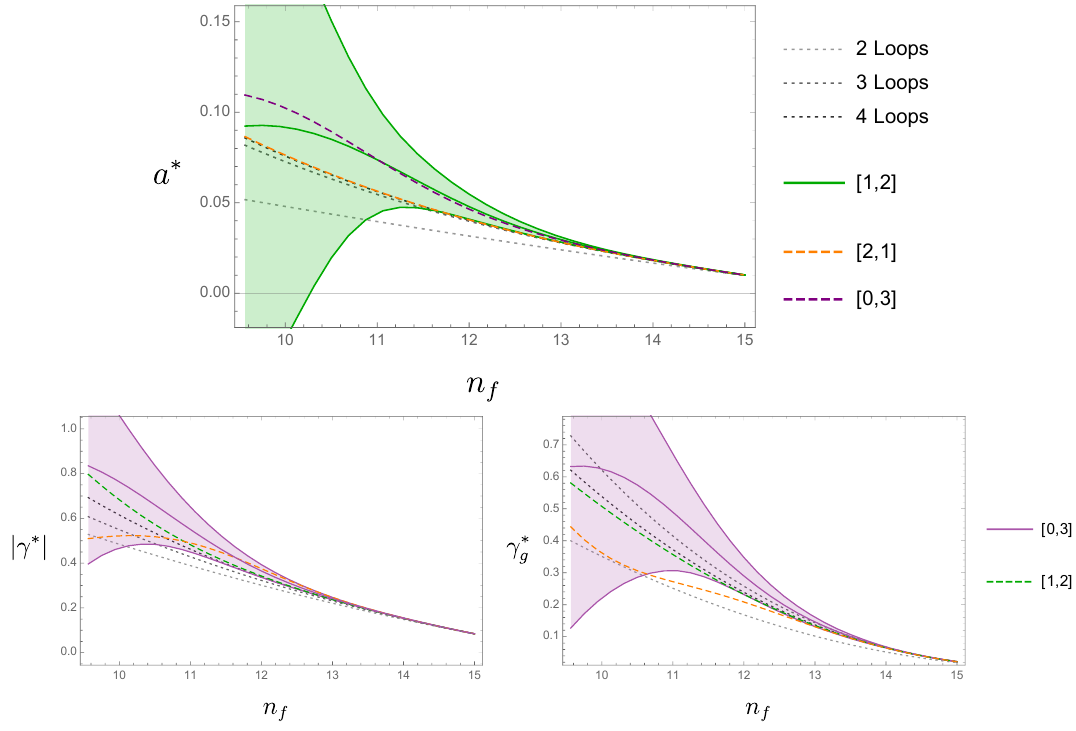
Figure 10 . The (cid:12)xed-point coupling a (cid:3) and the anomalous dimensions j (cid:13) j and (cid:13) g in QCD as a function of n f as obtained from the Pad(cid:19)e-Borel resummation of the Banks-Zaks conformal expan- sion. Grey dotted lines correspond to perturbative results, dashed lines denote the central values of the Pad(cid:19)e-Borel approximants indicated in the legend. The shaded area corresponds to the error associated to the selected approximant and its central value is given by the continuous line in the middle. In all panels the error band corresponds to c np =